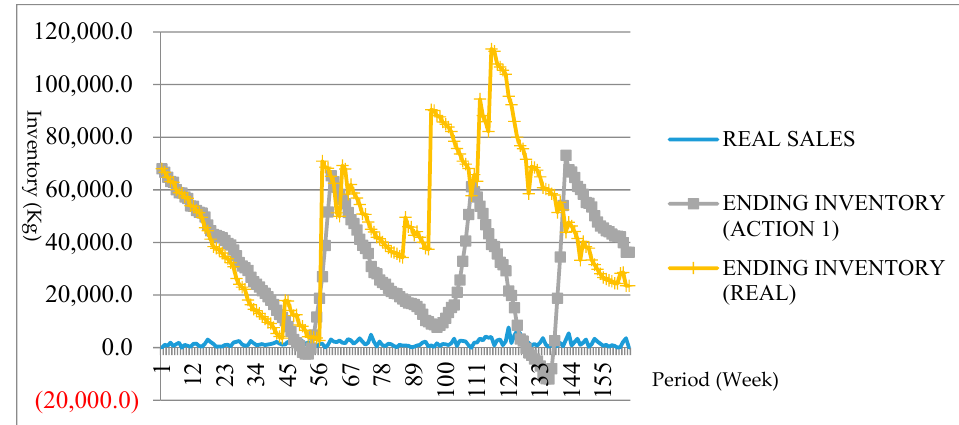
Figure A1 . Inventory charts of action 1. Figure A1. Inventory charts of action 1. Table A1. Transitions probability matrix of action 1. Table A1. Transitions probability matrix of action 1.